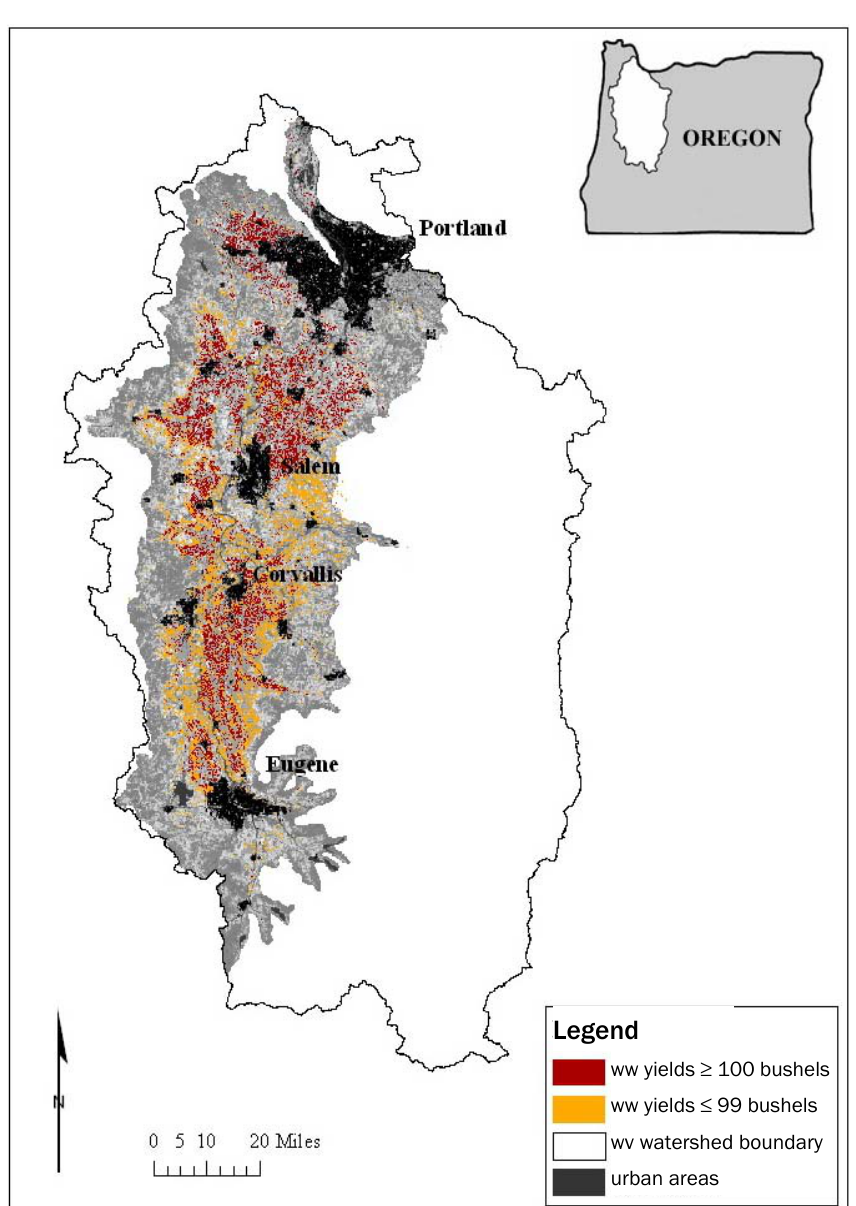
Figure 3. Map of the Willamette Valley’s (WV) Projected Soft White Winter Wheat Yields (ww) in Bushels per Acre on Grass Seed